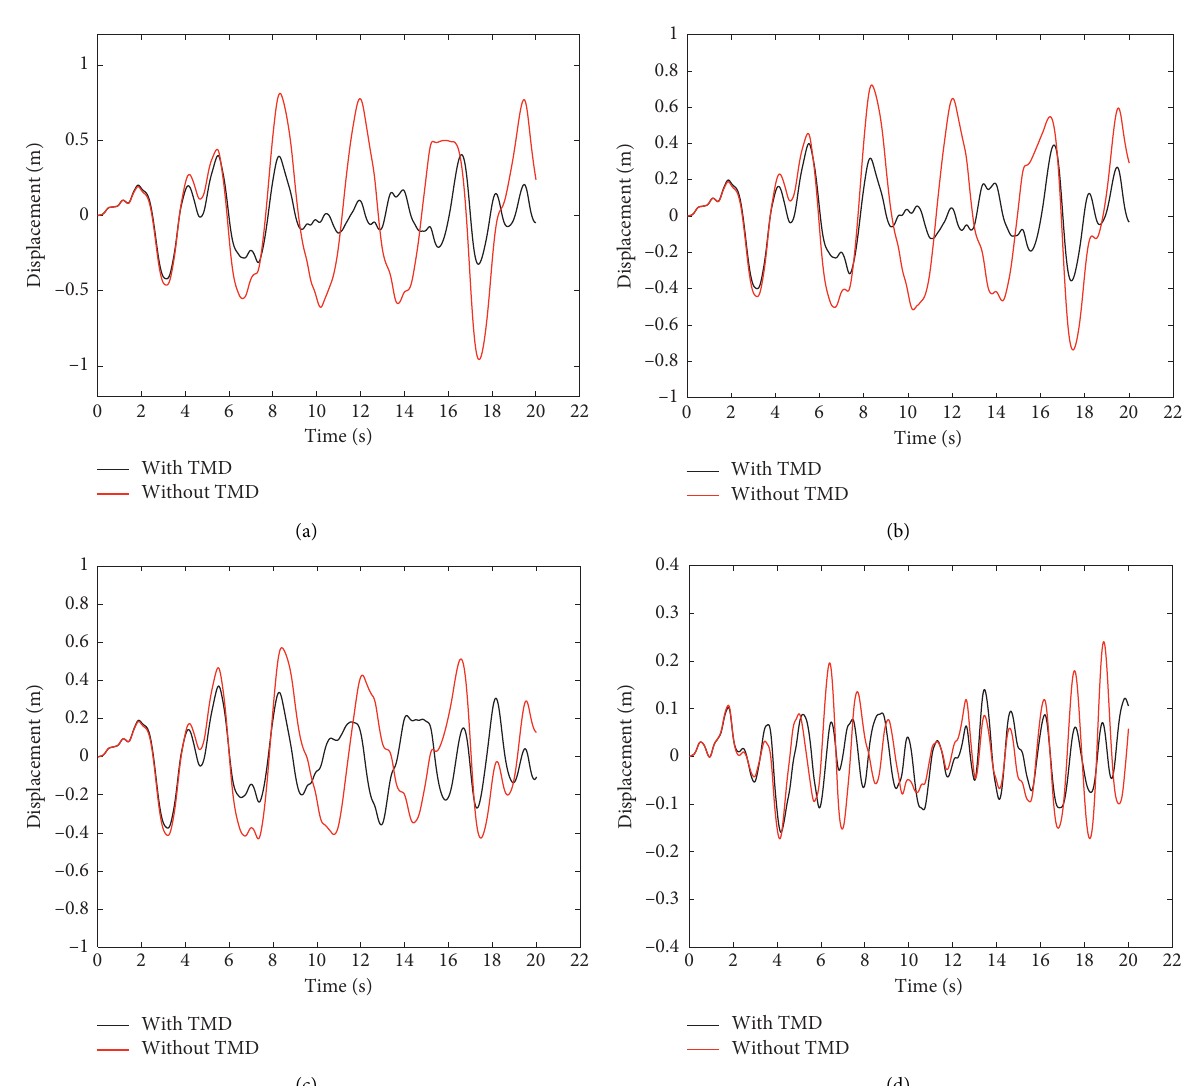
Figure 7: Comparison chart with or without TMD structure displacement (m) (Tangshan wave, China). (a) Fixed base. (b) Dense